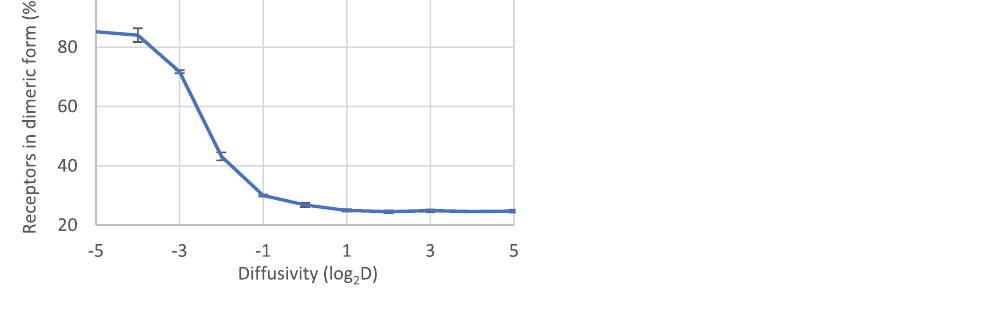
Figure 9. Decreasing receptor diffusivity increases dimerisation. Simulated testing of altered receptor diffusivity to assess receptor dimerisation, with otherwise fixed parameters. For convenience, receptor velocity was taken as v = D ½ . Diffusivity varied from 2 –5 , 2 –3 , …, to 2 5 . The simulation shows a decrease in dimer number at an increased diffusivity. Data are shown in a semi-log2 scale; mean ± SD (n = 3